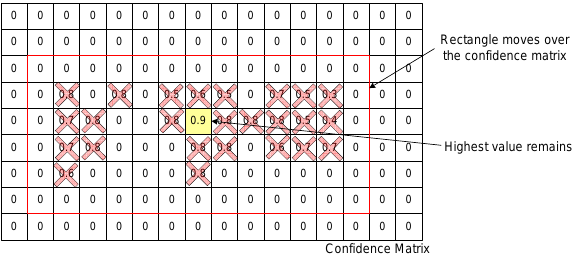
Figure 4: Suppression of multi detection